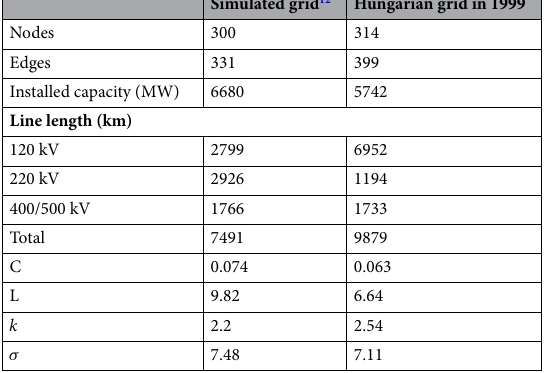
Simulated grid 12 Hungarian grid in